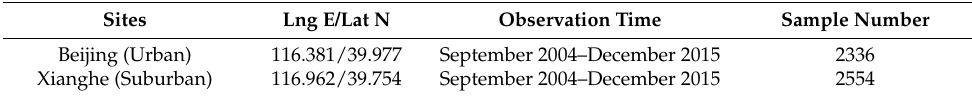
Table 1. AERONET